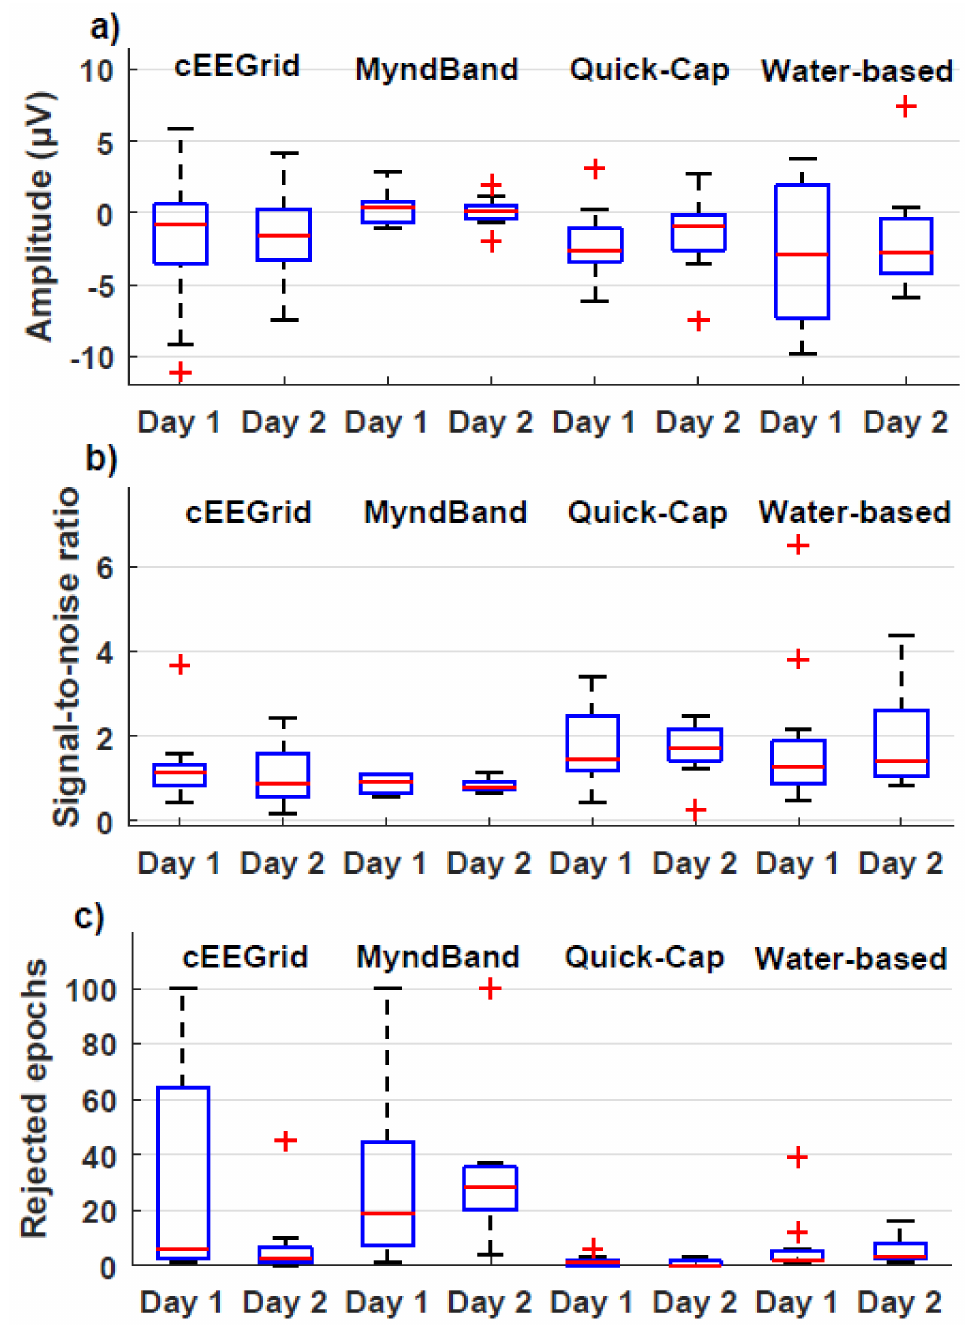
Figure 3. Boxplots with quartiles for the signal quality analyses. ( a ): Average amplitude around the movement onset; ( b ): Signal-to-noise ratio; ( c ): Number of rejected epochs for a single